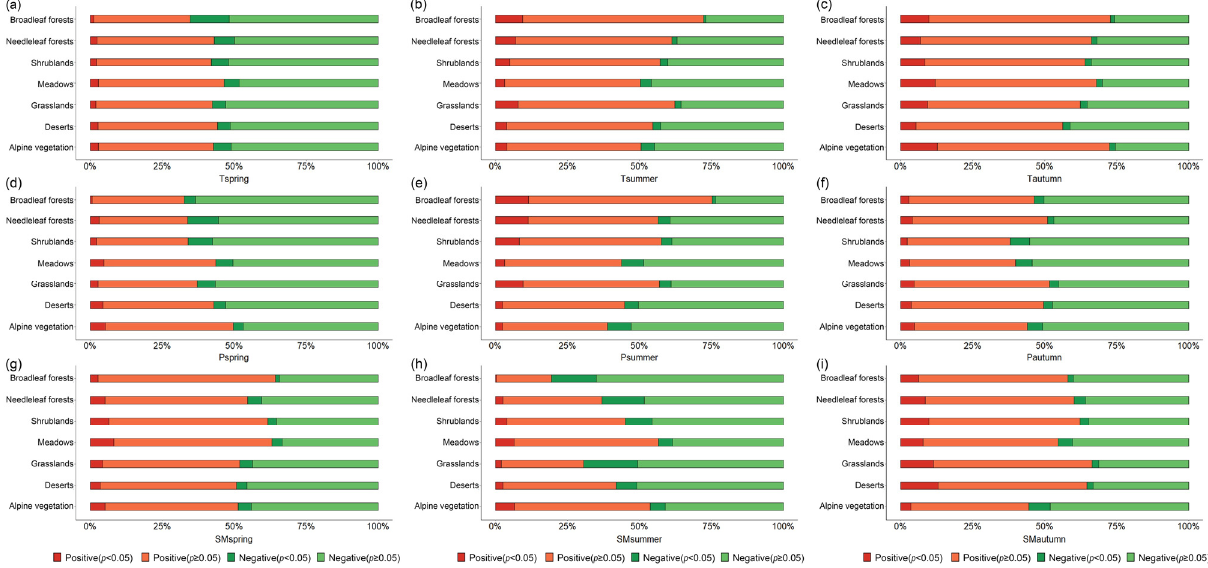
Figure 9. Percentages of correlation between EOS and different driving factors in different vegetation types. The driving factors were ( a , b , c ) seasonal temperature (Tspring, Tsummer, and Tautumn are spring, summer, and autumn temperature, respectively), ( d , e , f ) seasonal precipitation (Pspring, Psummer, and Pautumn are spring, summer, and autumn precipitation, respectively), and ( g , h , i ) seasonal soil moisture (SMspring, SMsummer, and SMautumn are spring, summer, and autumn soil moisture, respectively).